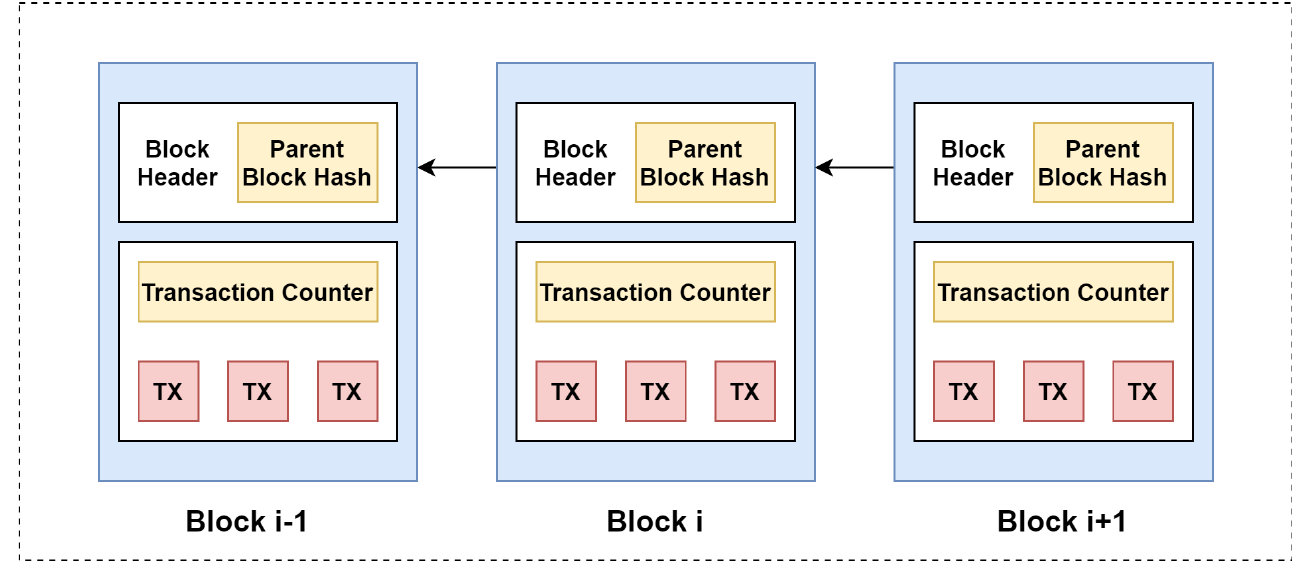
Figure 1. Blockchain architecture.